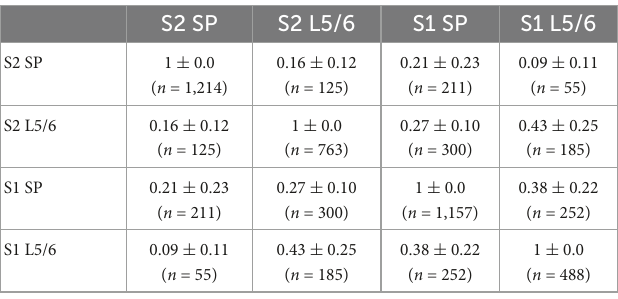
The number of data points (n) refers to the number of coincident bursts detected in a totaloffiveslices.